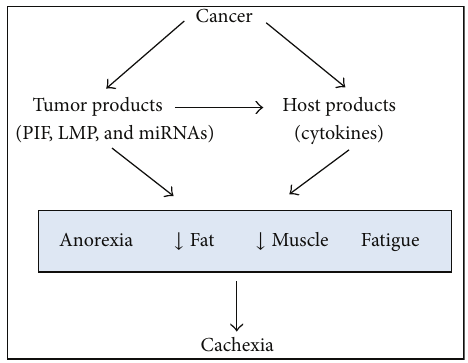
Figure 3: miRNA as part of cachexia modulation as an addition to the Tisdale proposition